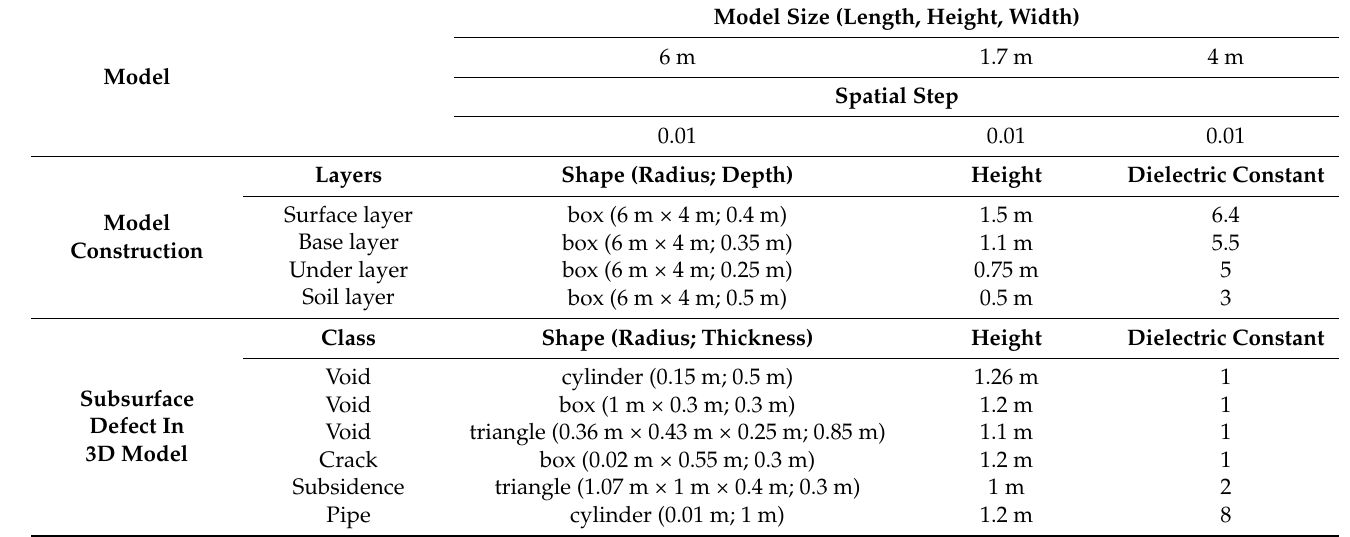
Table 3. Parameters of the modeling methods in Figure